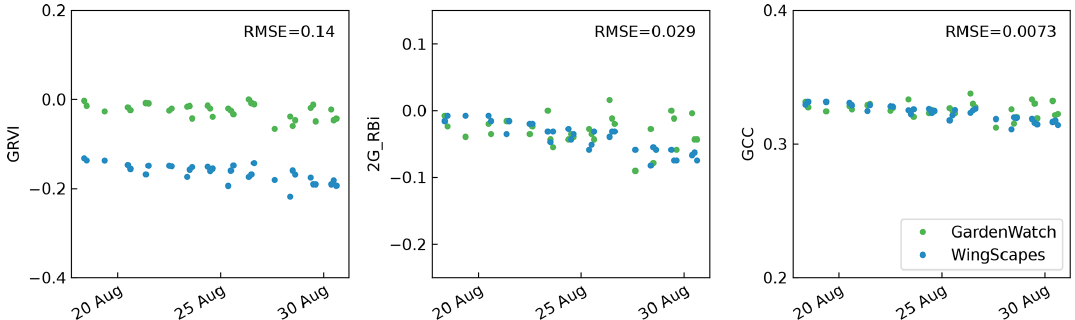
Figure 4. Comparison of the GardenWatchCam and WingScapes cameras for three different vegetation indices (GRVI, 2G_RBi, and GCC) during a 2-week period in August 2017. The root mean square error (RMSE) between the two cameras is shown in each